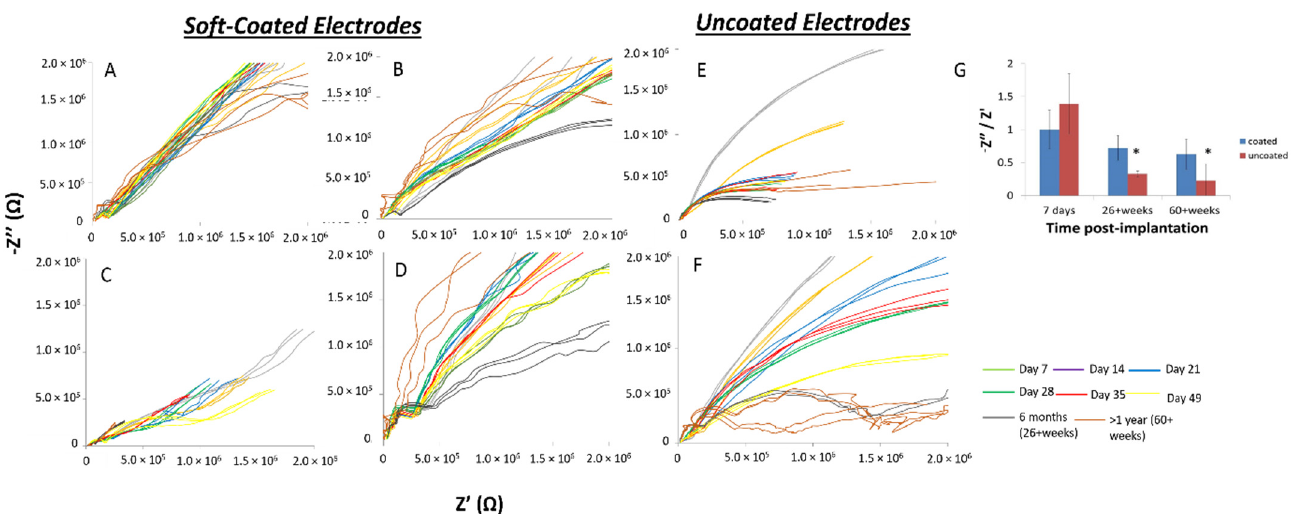
Figure 8. Broad-band complex impedance spectra for coated ( A – D ) and uncoated ( E , F ) tungsten electrodes over > 432 days (60+ weeks). Uncoated electrodes become more resistive (slope decreases) with longer implantation times. Soft-coated electrodes in ( A – D ) maintain similar slopes over long-term implantation. The soft-coated electrode in ( D ) shows more variability with > 6 months (+26 weeks) data having a more resistive slope compared to >1 year (60+ weeks) having a more capacitive slope. ( G ) shows the comparison of the slopes from a linear fit of averaged complex impedance spectra ( − Z ″ /Z ′ ) for soft-coated and uncoated electrodes. The values for the uncoated electrodes decreased significantly (* p < 0.05), which is indicative of the impedance becoming more resistive with longer implantation times.